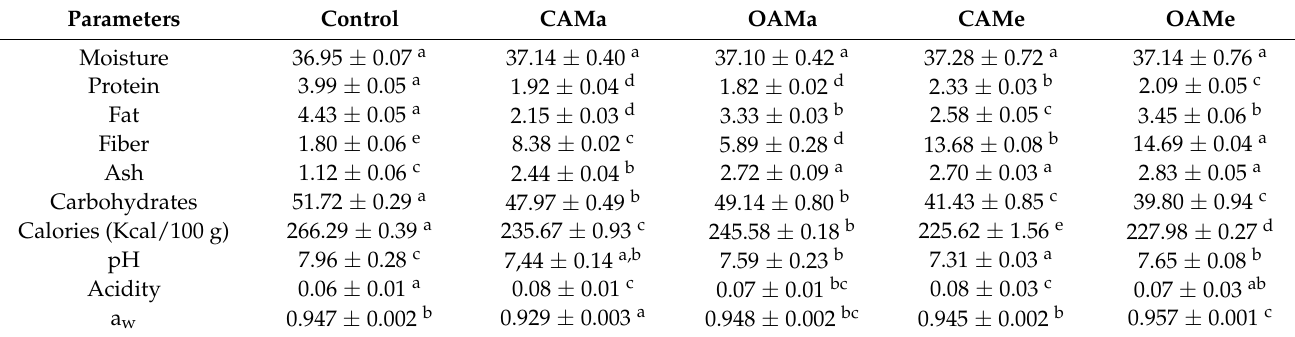
Table 2. Proximate composition (%), caloric content (Kcal/100 g), pH, acidity (as % of lactic acid) and aw of gluten- free